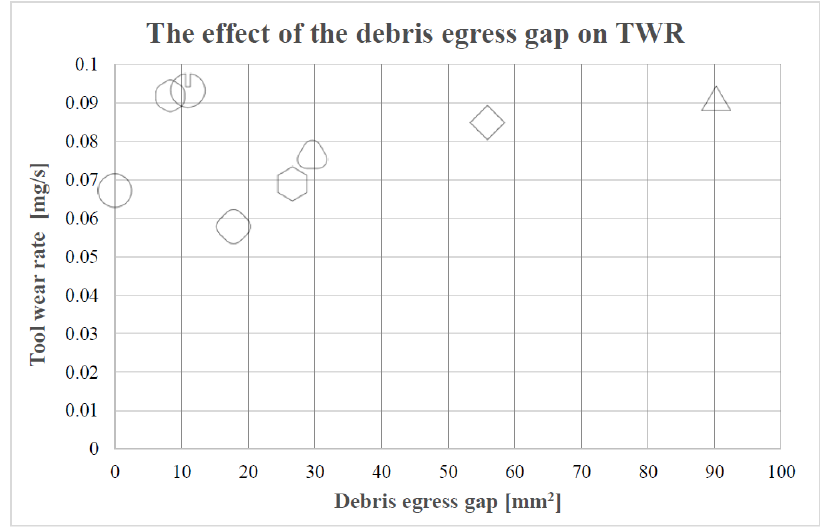
Figure 8. The relationship between TWR and the debris egress gap.